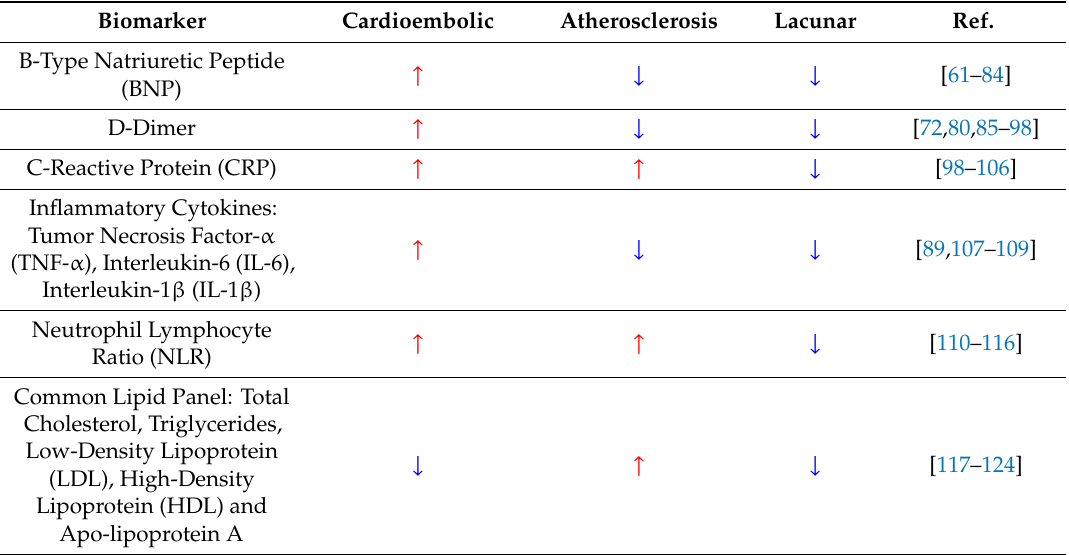
Table 1. Blood-based biomarkers that best classify ischemic stroke etiologies, ↑ elevated vs. ↓ reduced. Biomarker